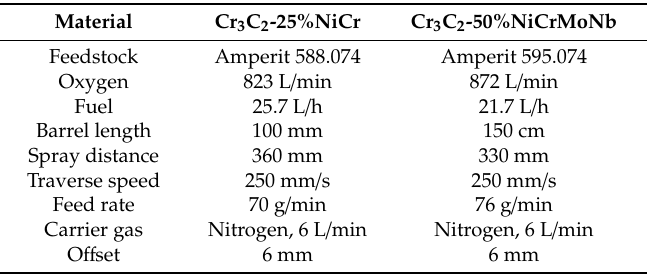
Table 1. Coatings deposition